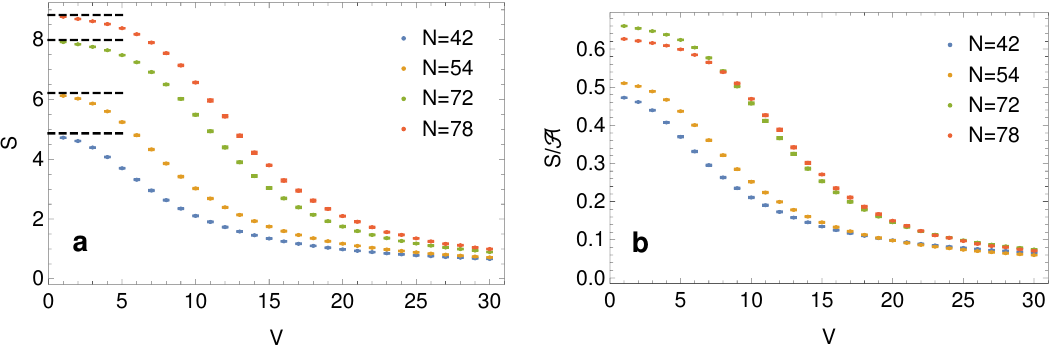
Figure 7: Panel a . Entanglement entropy S as a function of the disorder V and for different sample sizes. The dashed lines are the bipartite entanglement entropy for random states, averaged over 10 4 realizations, and represent the limiting value of the entanglement entropy of eigenstates as V → 0. Panel b . Entanglement entropy rescaled with the size of the boundary A of the bipartition, showing a collapse, and thus an area-law scaling, at high disorder